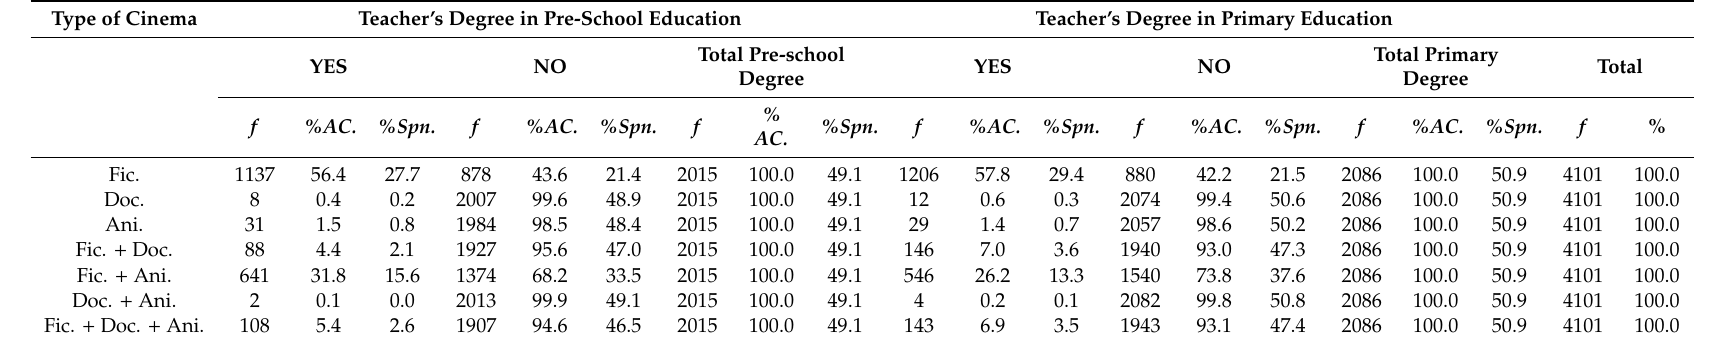
Table 11. Percentages and frequencies of the type of cinema seen by the students, according to the type of teacher (cid:48) s degree. Type of Cinema